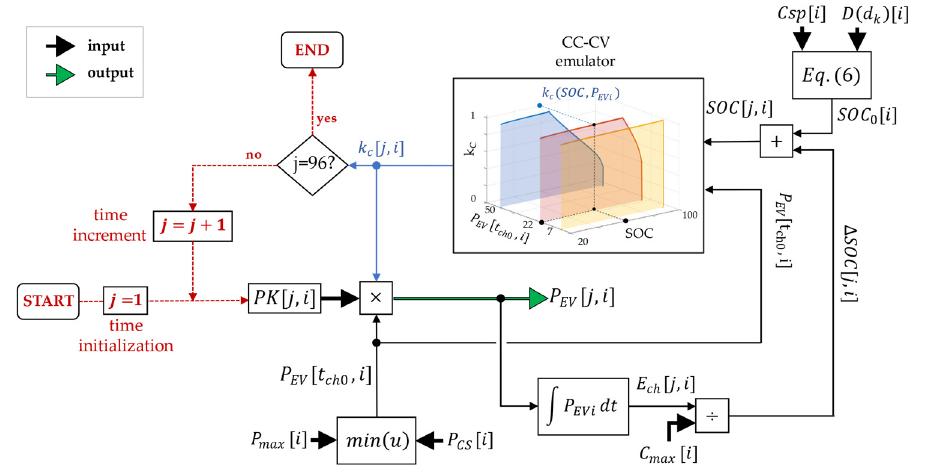
Figure 7. EV charging power flows algorithm. The flow chart shows the logics that allow forecasting the daily power required by an EV, which is a user of the parking.